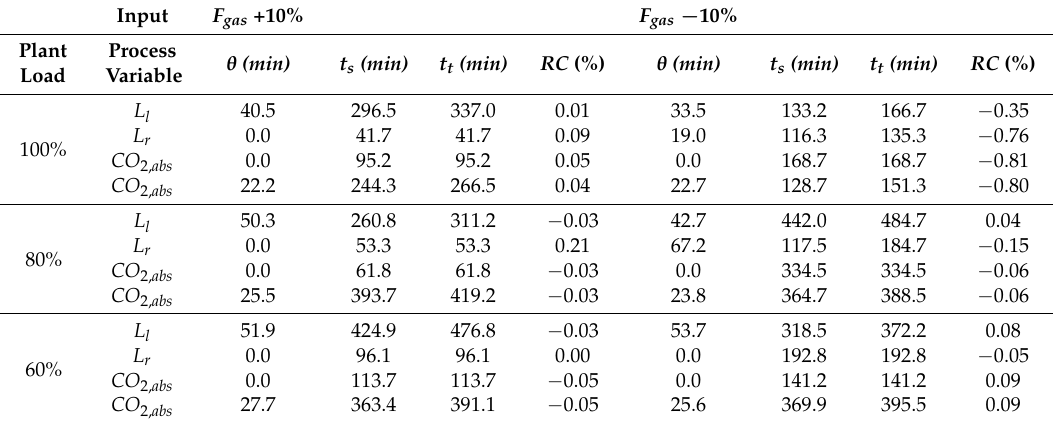
Table A1. Open-loop response to ± 10% step-changes in flue gas mass flow rate for three different operating points of the pilot plant. Responses in CO 2 lean loading L l , CO 2 rich loading L r , CO 2 absorbed, and CO 2 desorbed.